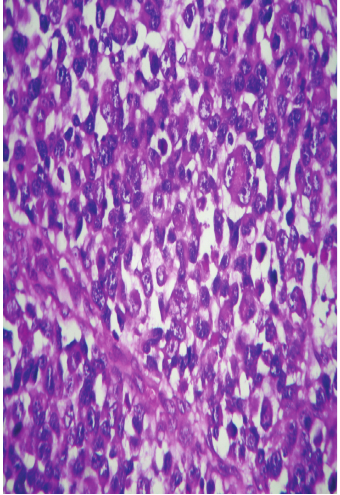
Figure 4: Embryonal rhabdomyosarcoma consisting almost entirely of differentiated rhabdomyoblasts (H&E staining, ×